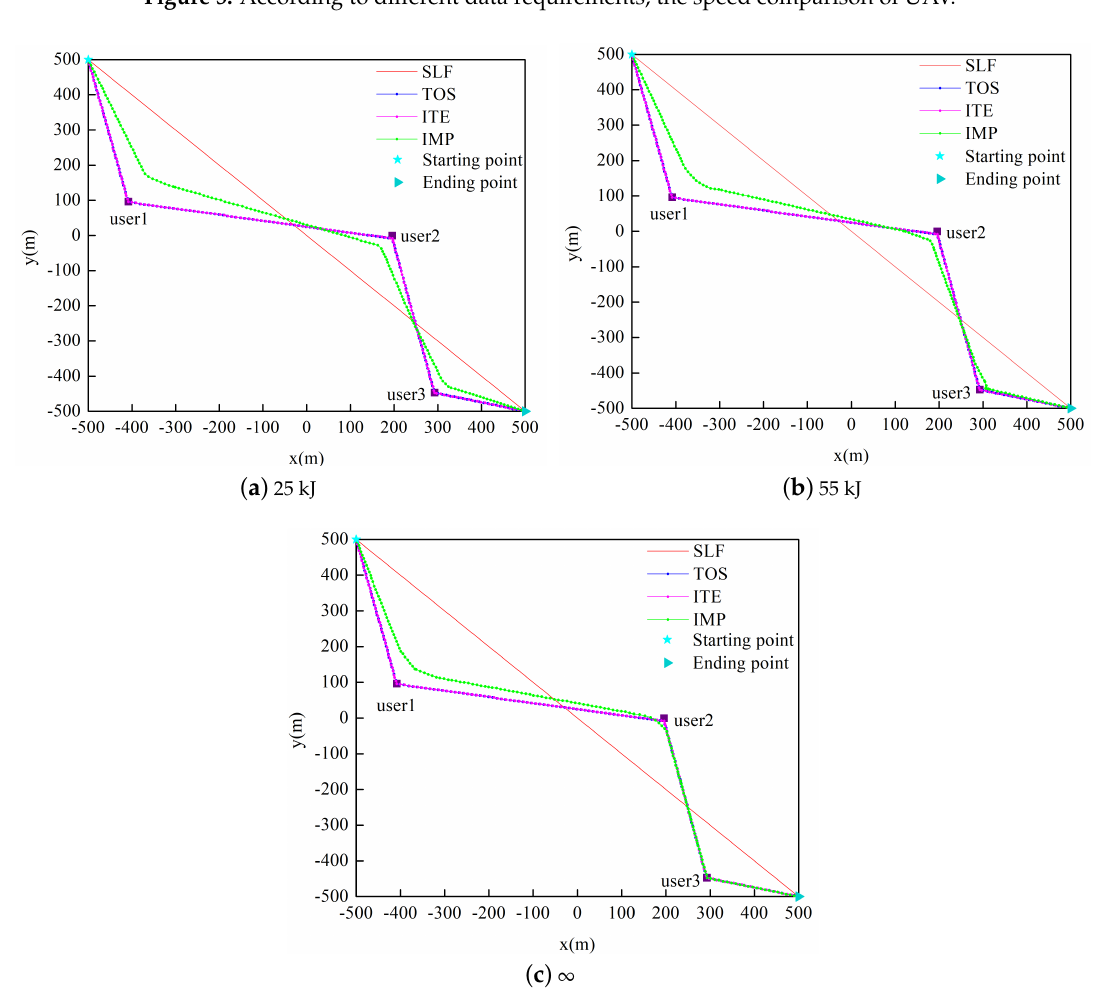
Figure 6. According to different energy constraints, the trajectory comparison of